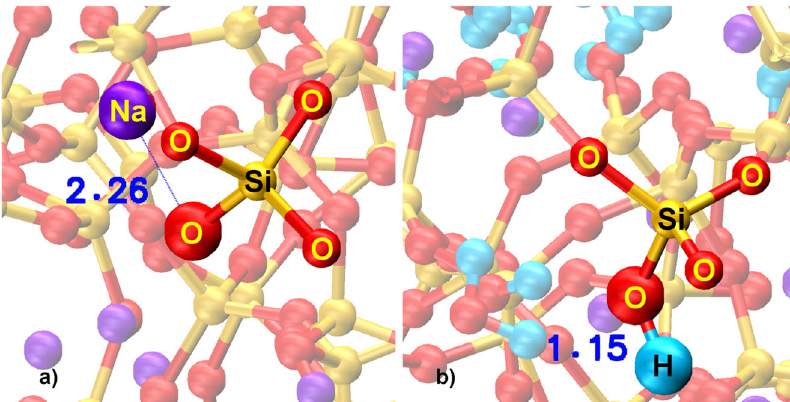
Fig. 1 Representative Na + and H + ion-exchange reactions at the sodium silicate glass – water interface. a The con fi guration before the ion- exchange process, showing an NBO − and Na + nearby; and b the con fi guration after the exchange and formation of silanol group. The O, Si, H, and Na are colored by red, orange, cyan, and purple, respectively. The larger spheres represent for the monitored atoms, and distances between O and monitored Na/H atoms are also